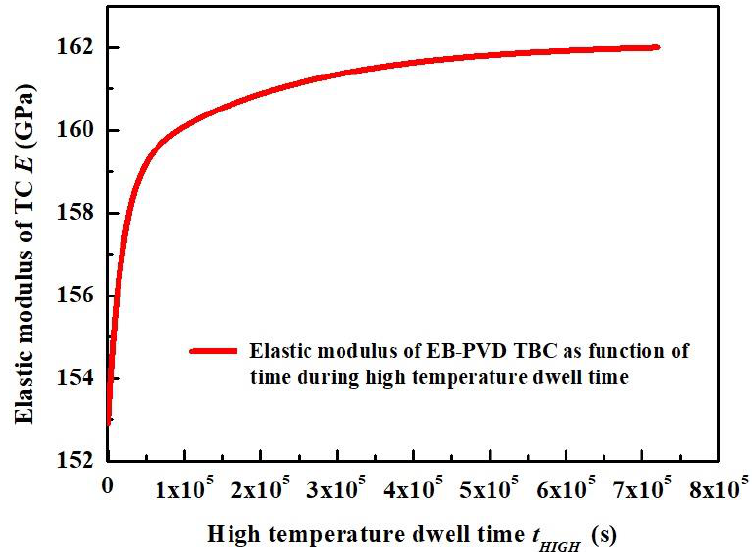
Figure 6. The variation of elastic modulus during high-temperature dwell period due to sintering.